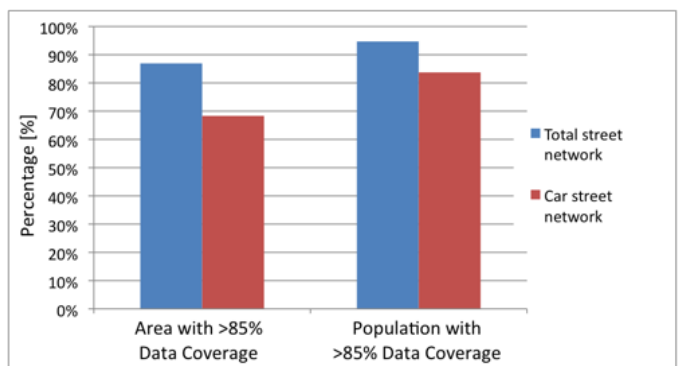
Figure 8. Correlation between OSM Data Coverage and Area, and OSM Data Coverage and Population (June 2011).